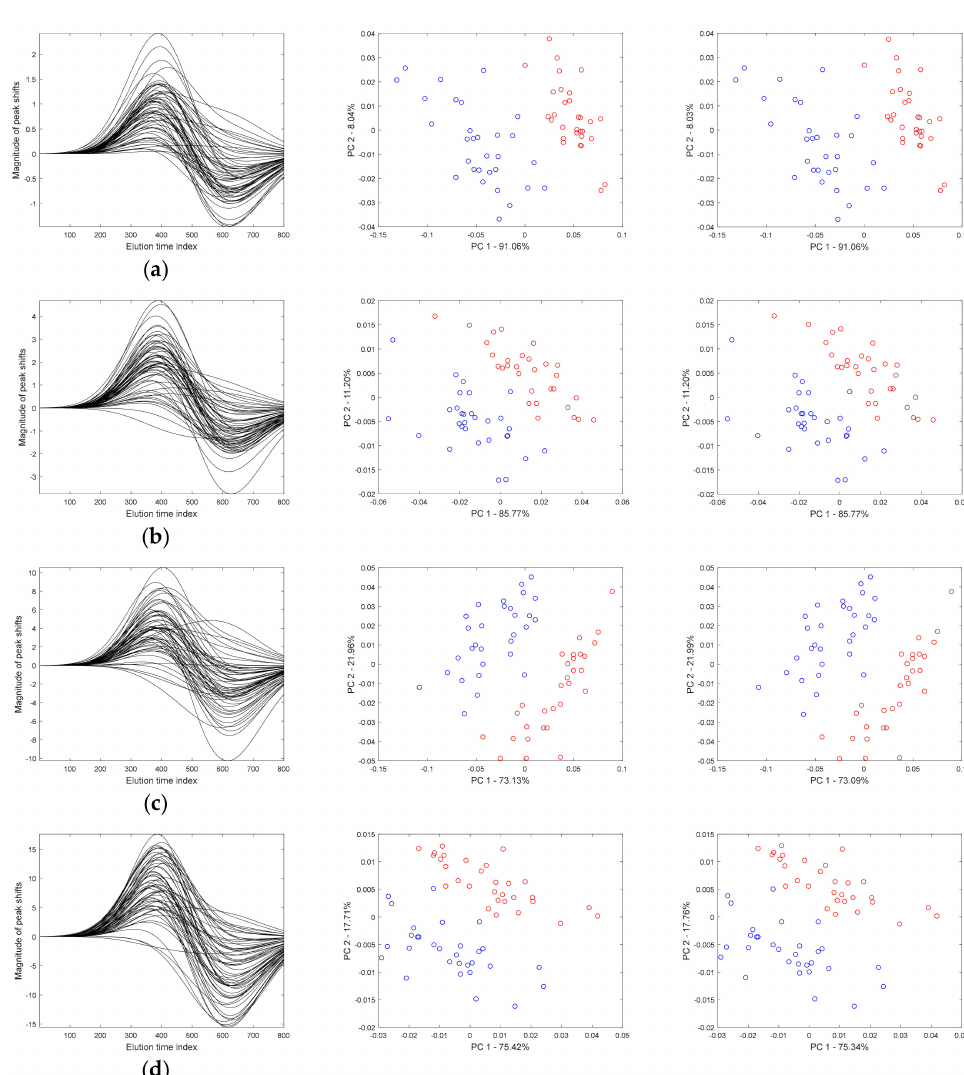
Figure 7. Set of warping functions and the corresponding projections of samples described by second-order chromatograms without peak shifts and with peak shifts on the plane defined by the first two principal components obtained from the Gram PCA approach, respectively, for four different levels of allowed peak shifts up to ( a ) three sampling points, ( b ) nine sampling points, ( c ) 20 sampling points, and ( d ) 33 sampling